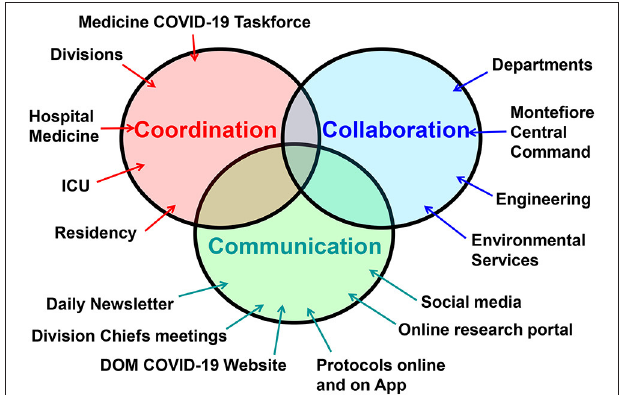
FIGURE 2 | The 3C framework consists of three elements: coordination between the department of medicine (DOM) divisions, ICU, Covid-19 units, residency training program, as well as other arms of the DOM. This was led by the Medicine Covid-19 Taskforce; Communication between all arms of the DOM was achieved via a daily newsletter, division chiefs meetings, online resources, and even social media; Collaboration with all arms of the institution, especially with Montefiore Medical Center administration and central command, was essential to ensure synergy and uniformity of efforts within the entire